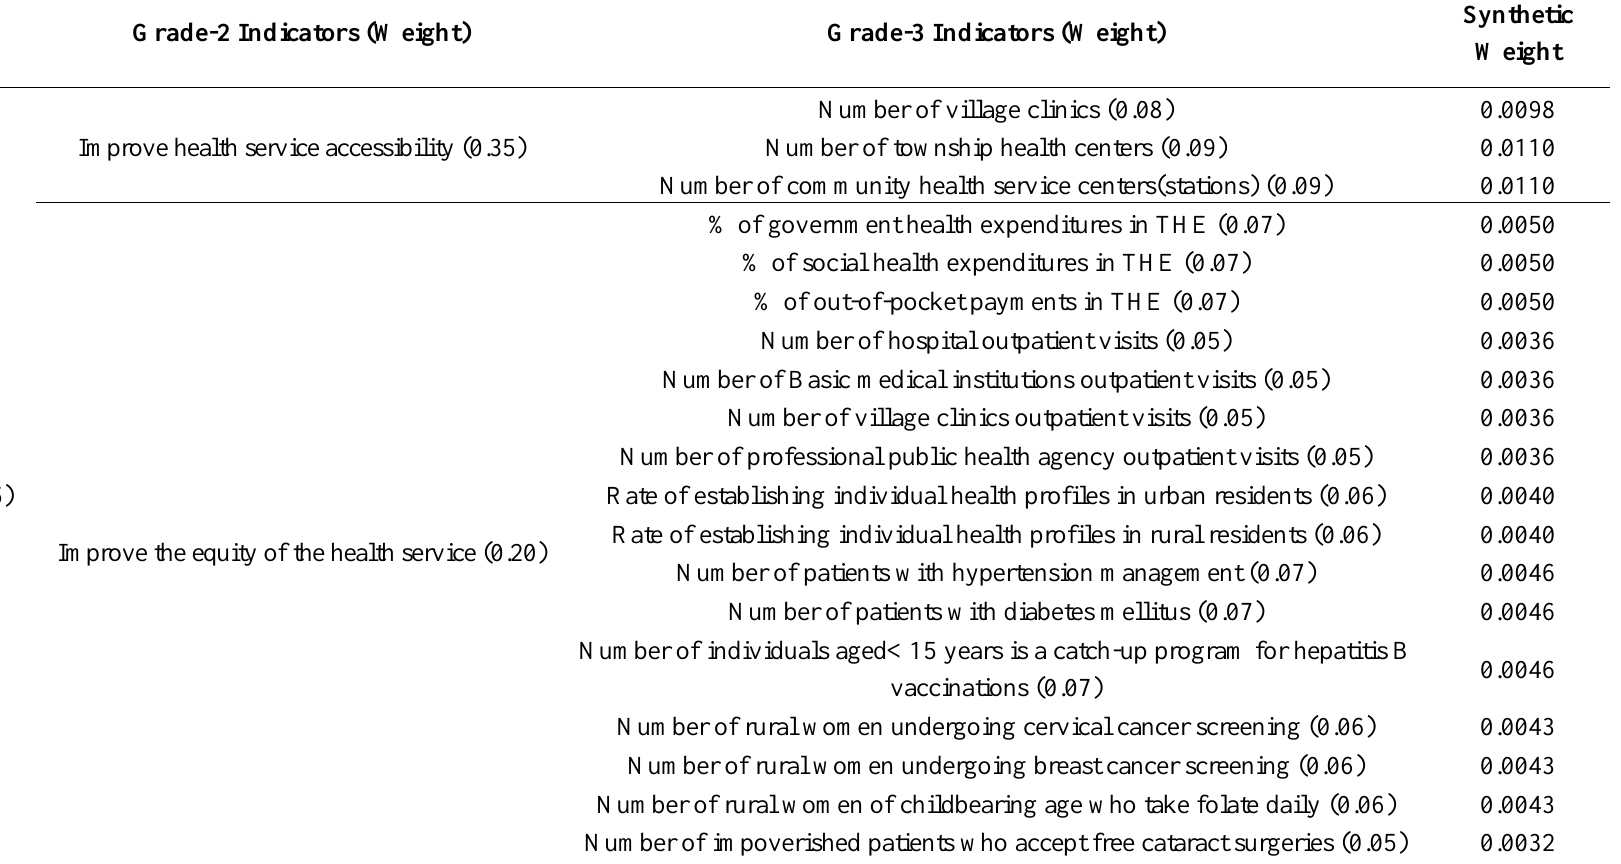
Table 2. Indicator system for healthcare